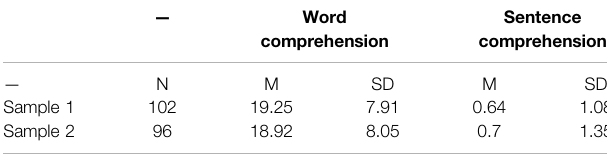
TABLE 2 | Means and standard deviations of the dependent variables at